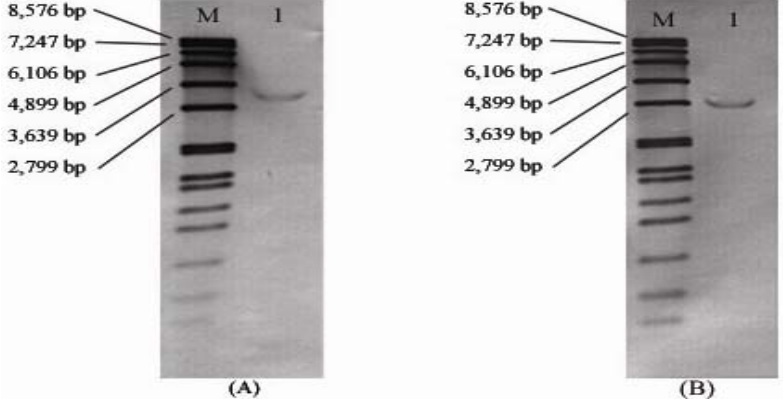
Figure 3. Southern analysis of (A) O. rufipogon ; (B) O. sativa ssp. indica cv. MR219 genomic DNA probed with a 320 bp 3' UTR fragment of RPK1 . Lane M contains a DIG-labeled DNA Molecular Weight Marker VII (Roche, Germany). Lane 1: genomic DNA digested with Eco RI.